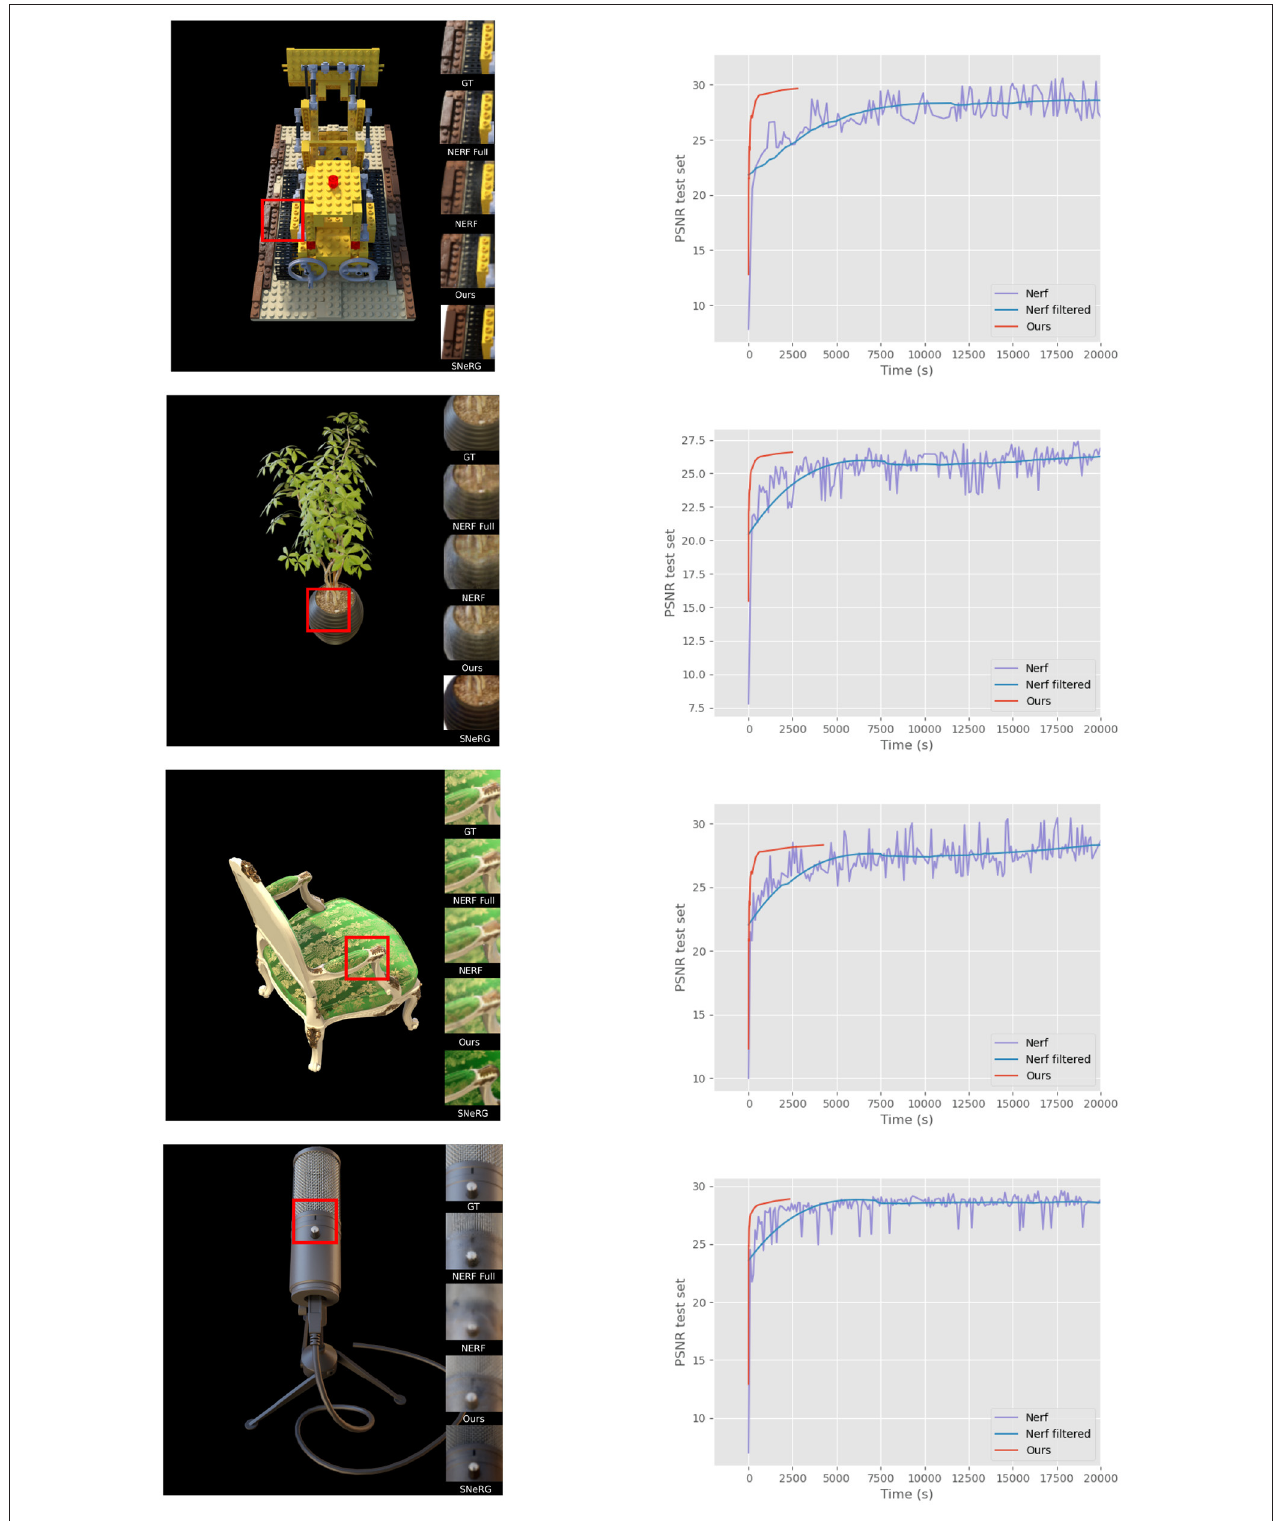
FIGURE 5 | Results on scenes from the NERF synthetic data set. Our reconstructions are shown in comparison with full NERF, NERF without view dependence, and SNeRG. On the right curves of PSNR vs. training time are shown for our method and NERF without view dependence. We can see that our method converges much faster, while obtaining a comparable level of